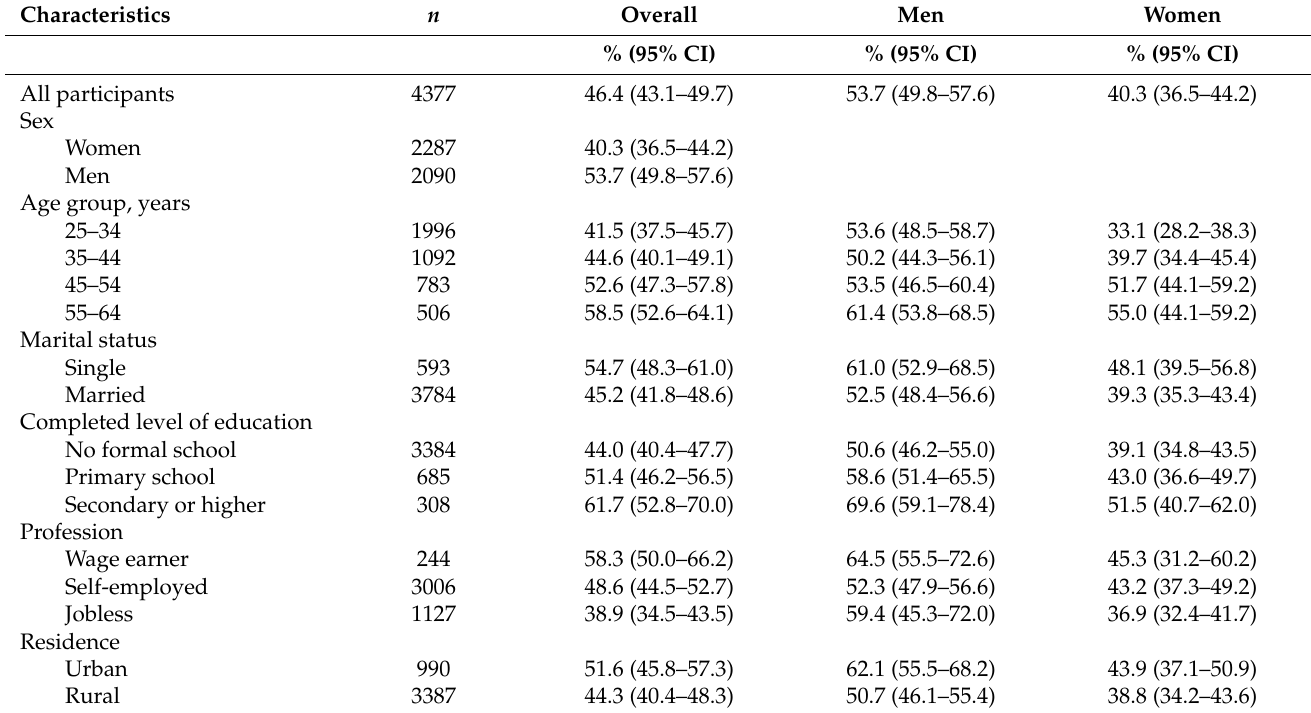
Table 2. Prevalence of the co-occurrence of lifestyle risk factors by